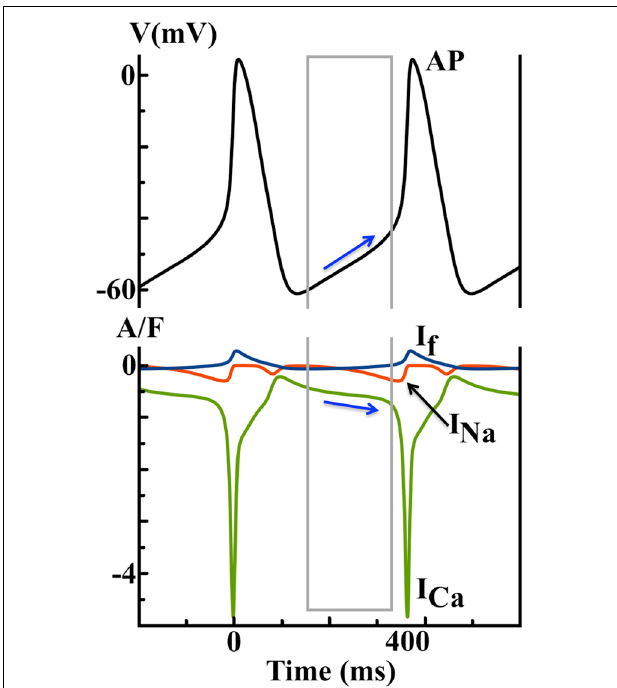
FIGURE 5 | Simulated AP and ionic currents using the YNI SAN model to illustrate the I Ca hypothesis. Blue arrows indicate that the changes in I Ca during diastolic depolarization finally trigger a spontaneous